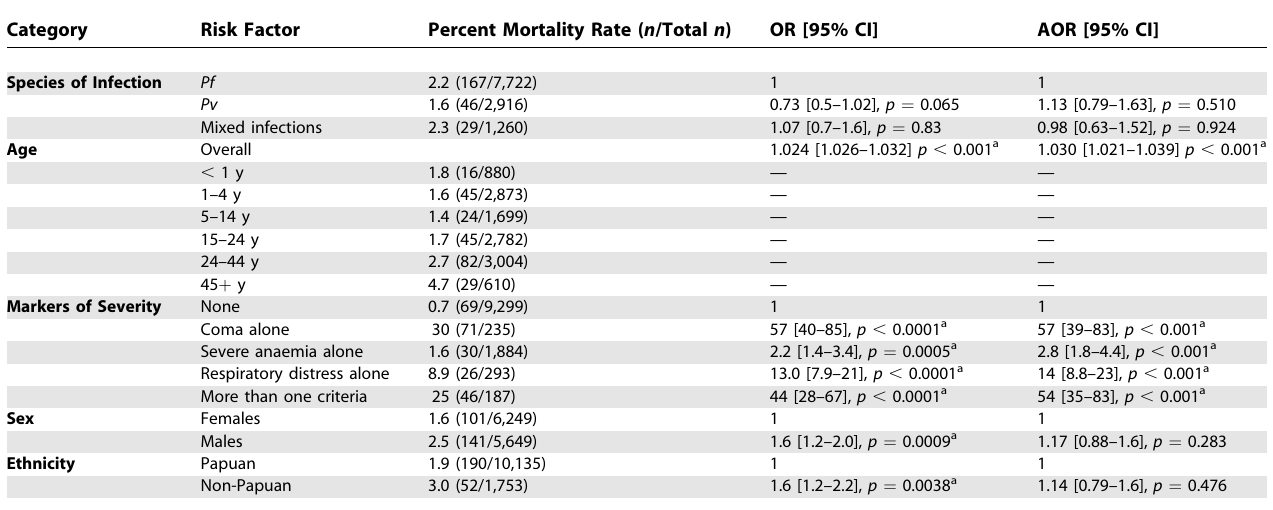
Table 3. Factors Associated with Mortality in Patients Hospitalised with Pv and/or Pf Infections Category Risk Factor Percent Mortality Rate ( n /Total n ) Species of